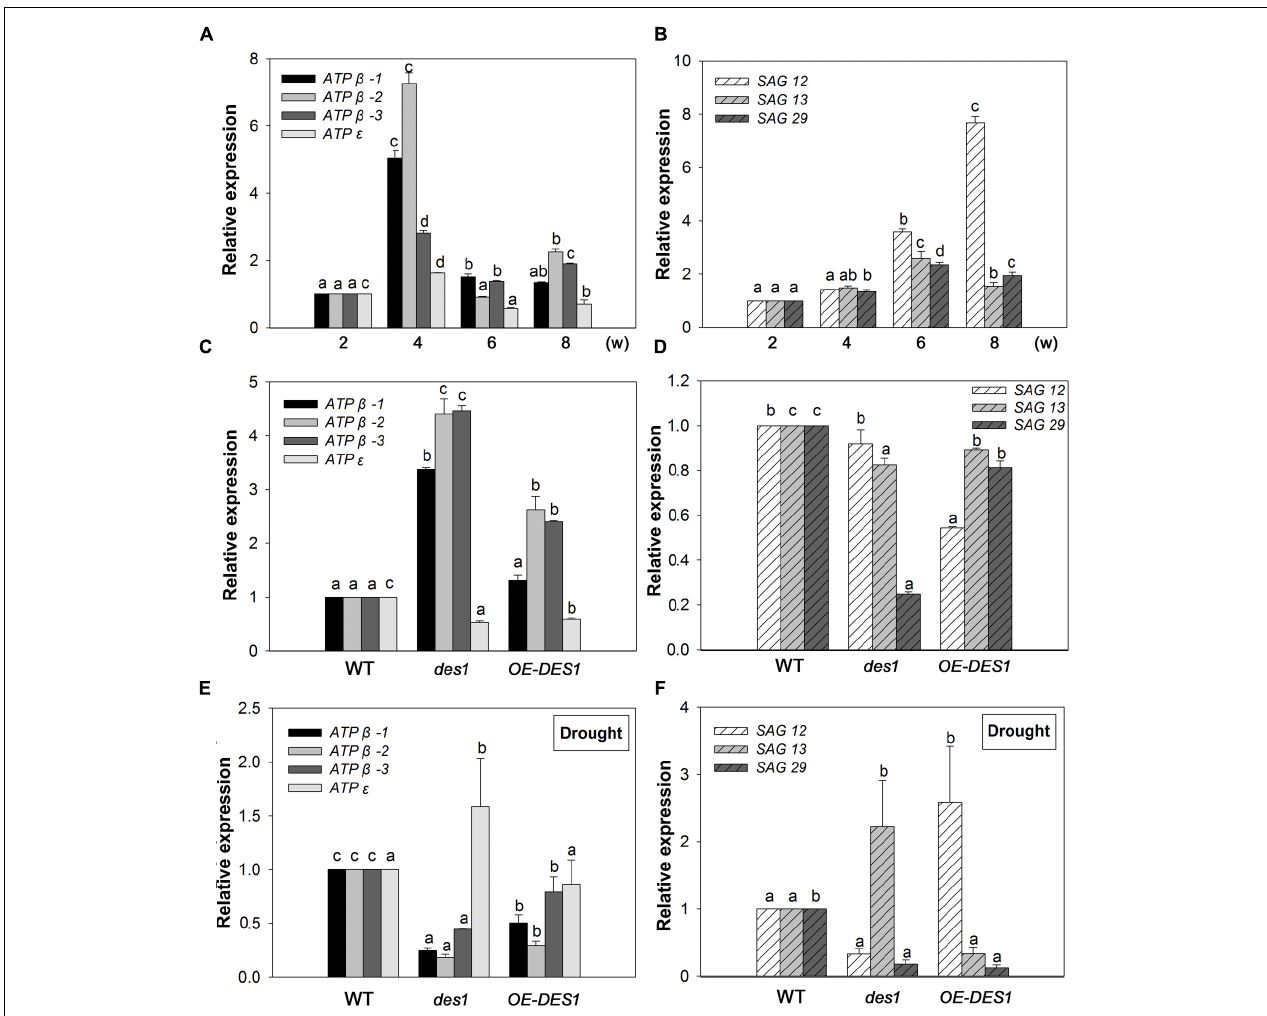
FIGURE 2 | Expression patterns of SAG s and ATP synthase-related genes. (A) Expression patterns of ATP synthase-related genes at different developmental stages. (B) Expression patterns of SAG s at different developmental stages. (C) Effects of endogenous H 2 S on the expression levels of ATP synthase-related genes. (D) Effects of endogenous H 2 S on the expression levels of SAG s. (E) Expression levels of ATP synthase-related genes under drought-stress conditions in WT, des1 and OE-DES1 . (F) Expression levels of SAG s under drought-stress conditions in WT, des1 and OE-DES1 . Data are means ± SEs of three independent experiments; bars marked with the same letter did not differ significantly at p <